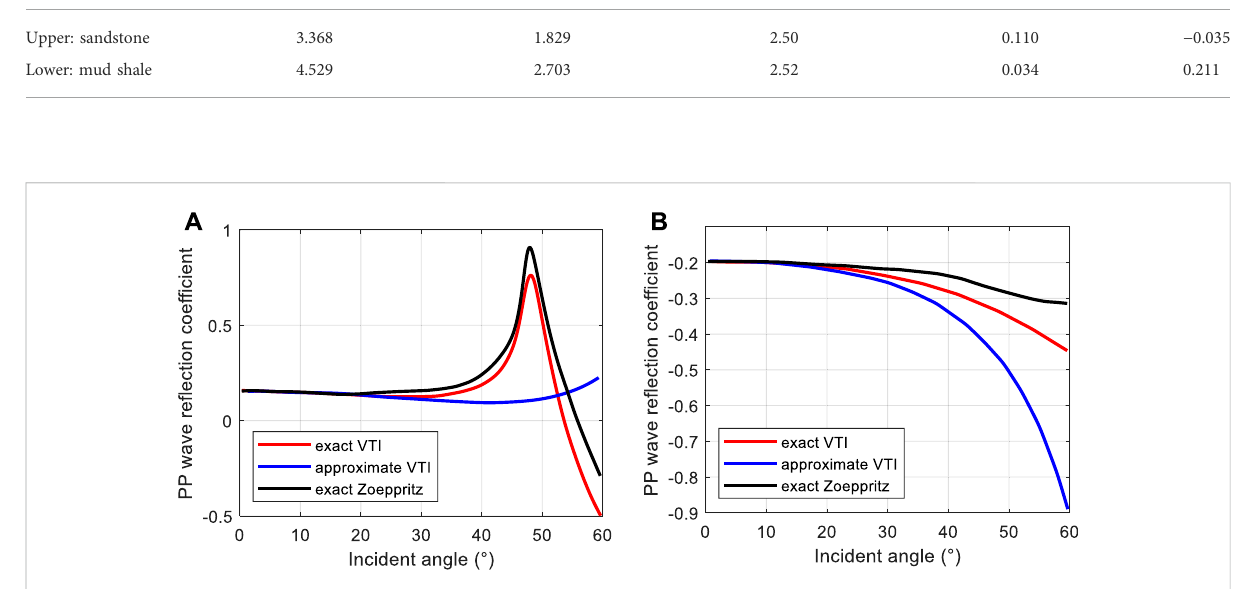
TABLE 2 Model parameters: the VTI/VTI interface from Thomsen [18].